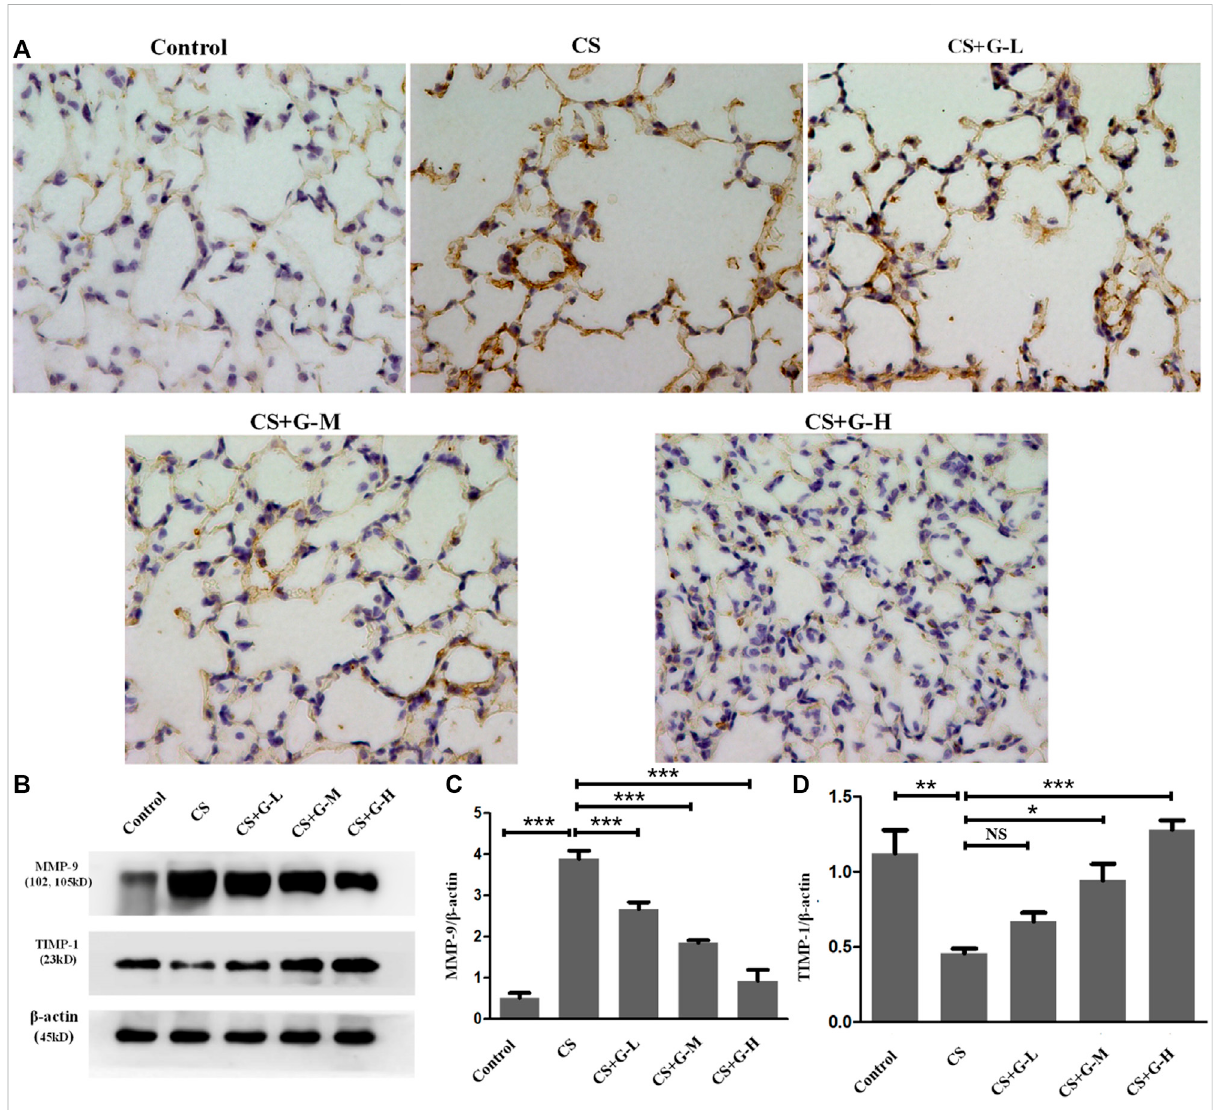
FIGURE 2 GHK-Cu restored the MMP-9/TIMP-1 balance in mice with cigarette smoke exposure. (A) Photomicrograph of immunohistochemical stained slides for MMP-9 from mice with chronic cigarette smoke or room air exposure. Representative images of micrographs at ×400 magni fi cation. (B) ExpressionofMMP-9andTIMP-1inlungtissuefromdifferentgroupswasassessedbywesternblot. (C,D) WesternblottinganalysisofMMP-9 (C) and TIMP-1 (D) protein expression in the lung tissue of mice in different groups. * p < 0.05, ** p < 0.01, *** p < 0.001, and NS means not signi fi cant ( p >